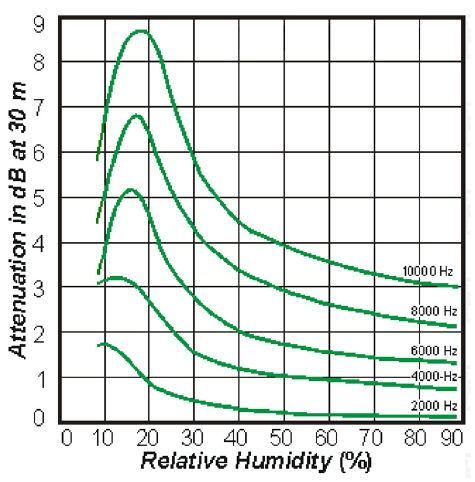
Figure 2. Sound attenuation as a function of sound frequency and relative humidity [9].